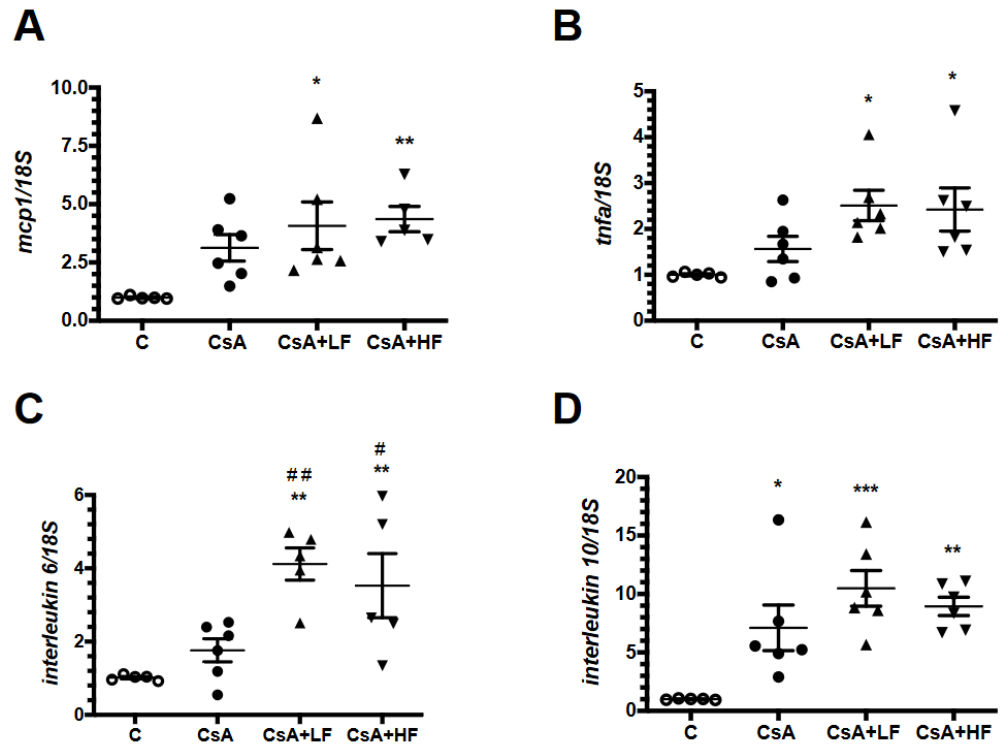
Figure 5. The co-administration of fosfomycin and CsA enhances the transcription of inflammatory cytokines. The mRNA levels of pro-inflammatory cytokines ( A ) mcp-1 , ( B ) tnf- α . and ( C ) IL-6 , and ( D ) IL-10 mRNA levels in control (C, white circles), cyclosporine (CsA, black circles), CsA with a low dose of fosfomycin (CsA + LF, black triangles up), and CsA with a high dose of fosfomycin treated rats (CsA + HF, black triangles down). n = 6. * p < 0.05, ** p < 0.01, and *** p < 0.01 vs. control group. # p < 0.05 and ## p < 0.01 vs. CsA group.